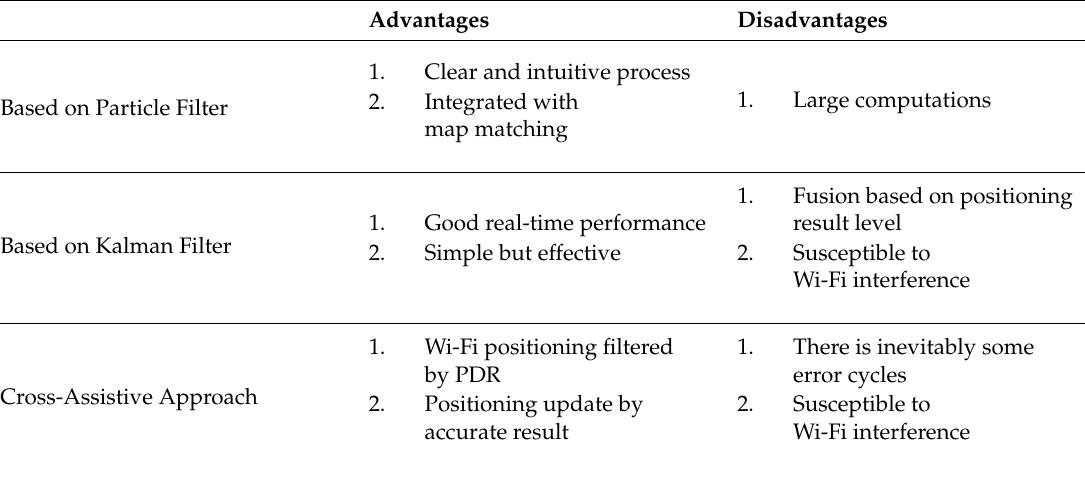
Table 1. A comparison of existing fusion